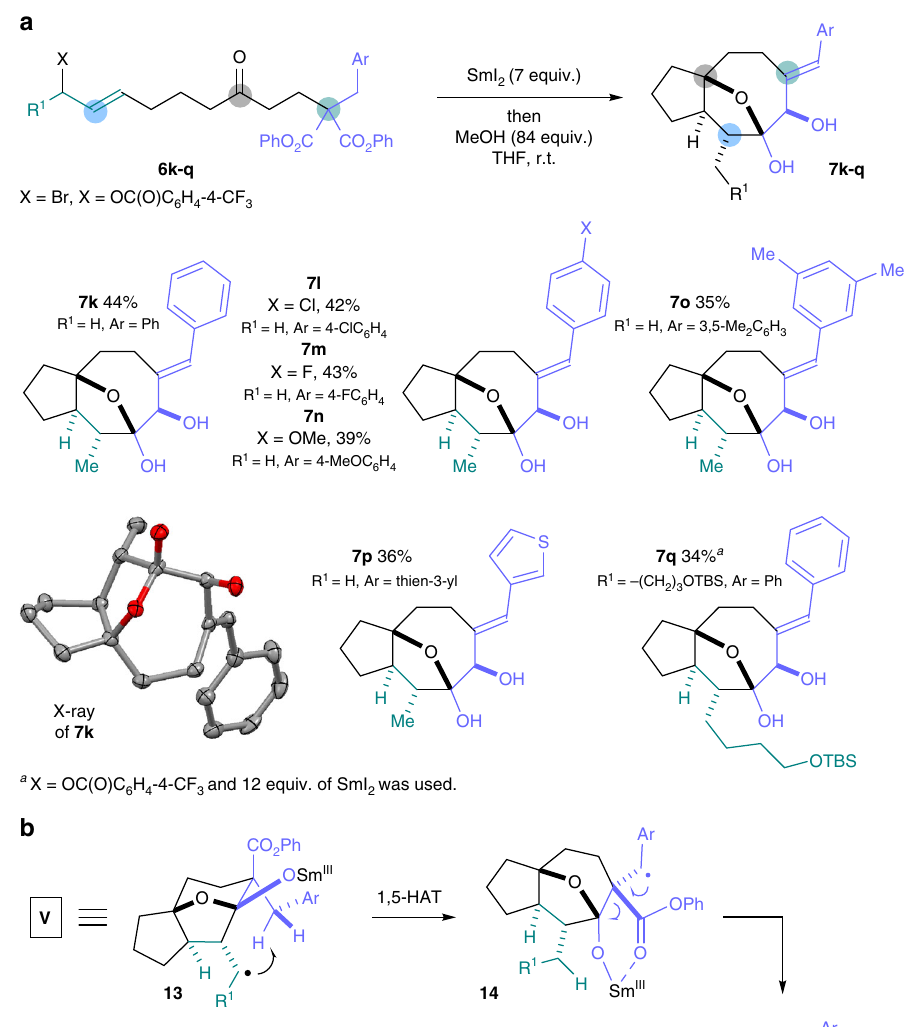
(Fig. 5a). The mechanism of the folding cascade is set out in Fig. 5b. After the initial Barbier cyclisation – lactonisation – lactone cyclisation sequence (see Fig. 2), 1,5-HAT in key radical intermediates 13 allows activation of the benzylic position to give radicals 14 . In contrast to the pathway involving tertiary radicals 9 , the benzylic radicals 14 undergo fragmentation, presumably promoted by the formation of an alkene that is in conjugation with the aromatic ring and the ester carbonyl. The resultant ketyl- type radicals 15 undergo acyloin-type cyclisation to deliver ketones 16 that are then diastereoselectively reduced (Fig. 5b).